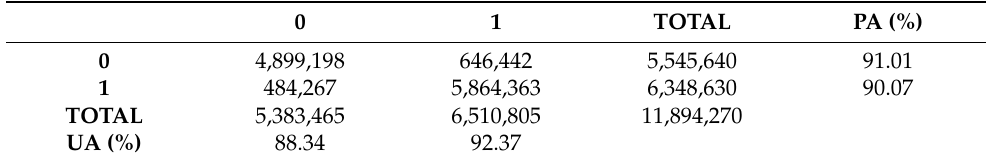
Table 5. Error matrix for Forcellini. 0 = not green; 1 = green. Rows = visual analysis; columns = NDVI + Topographic DB. UA = user’s accuracy; PA = producer’s accuracy.